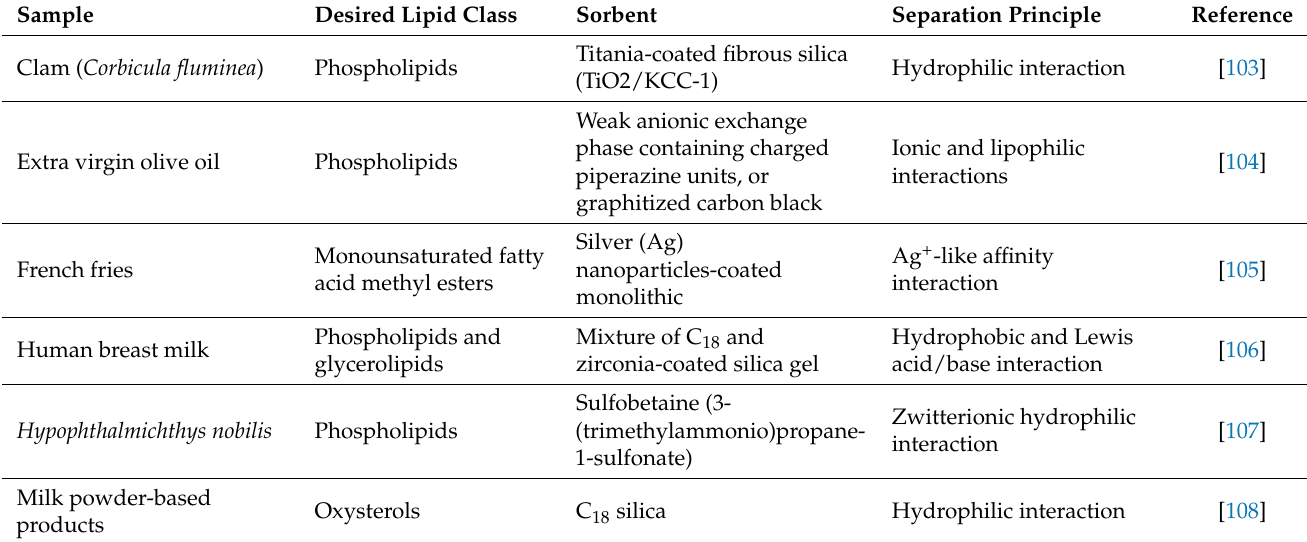
Table 4. Solid-phase extraction (SFE) of lipid